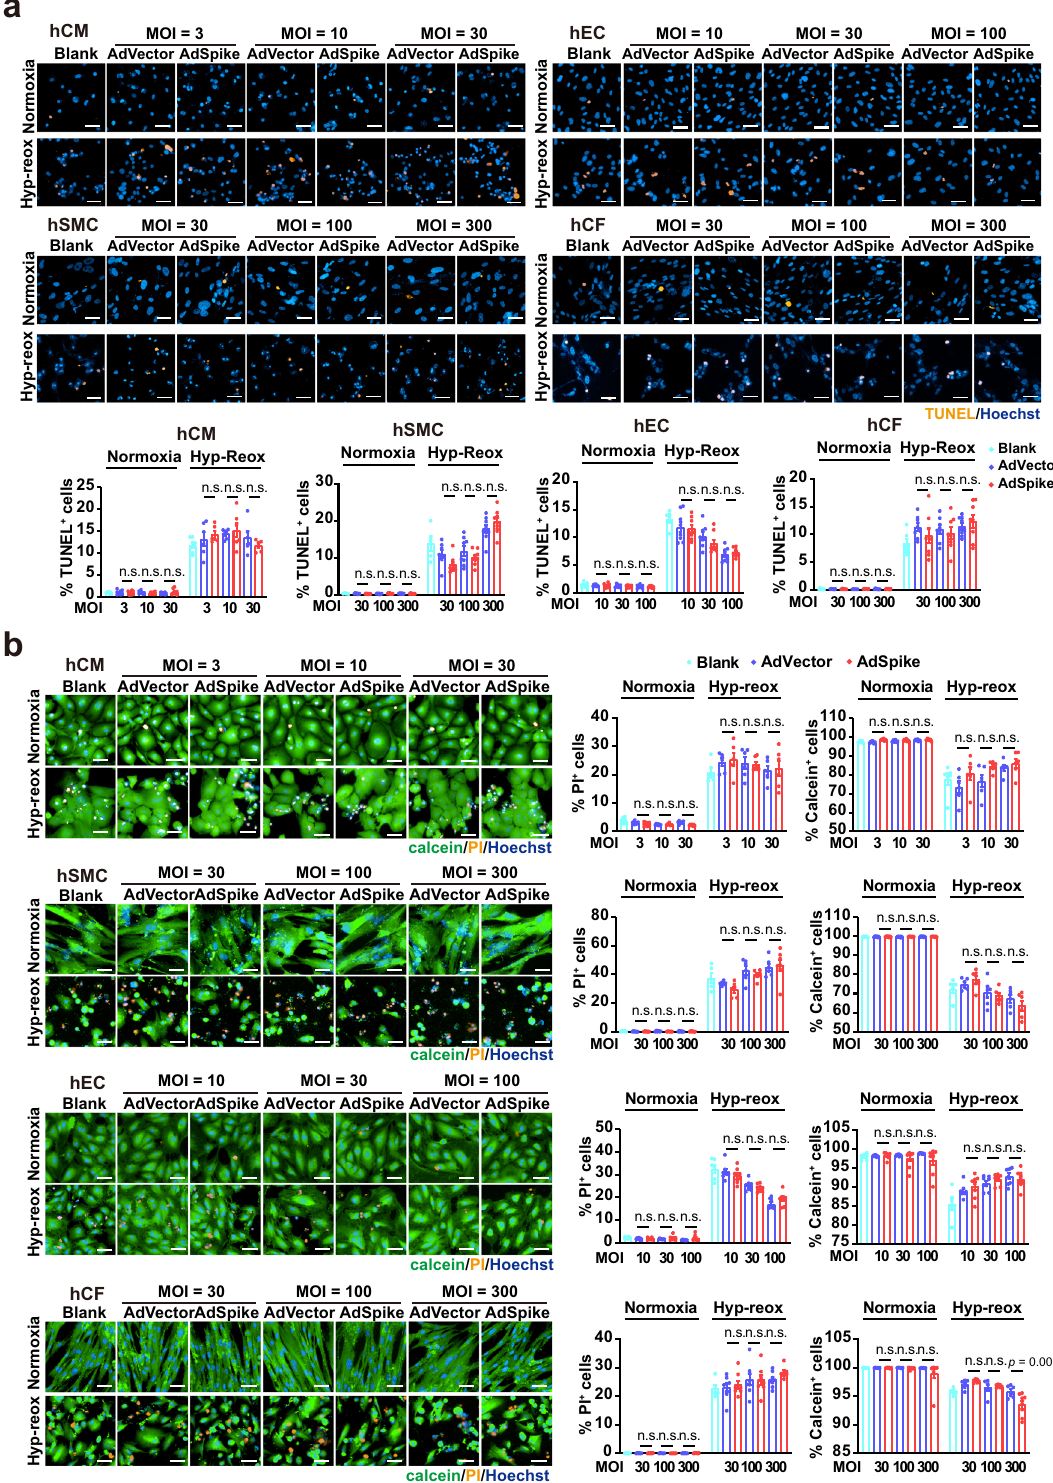
Fig. 2 AdSpike has little effect on cell survival of human cardiac cells with or without hyp-reox injury. a Representative and quantitative immunostaining analysis of the TUNEL + cells in hCMs, hSMCs, hECs, and hCFs infected by AdVector or AdSpike with or without hyp-reox injury. Scale bar, 50 μ m. n = 5 – 8 for each group. b Representative and quantitative calcein-AM/propidium iodide (PI) double staining in hCMs, hSMCs, hECs, hCFs infected by AdVector or AdSpike with or without hyp-reox injury. n = 5 – 8 for each group. Statistical signi fi cance was assessed using 2-way ANOVA with Turkey post-test. Scale bar, 50 μ m. Data are presented as mean ± SEM; n.s., not signi fi